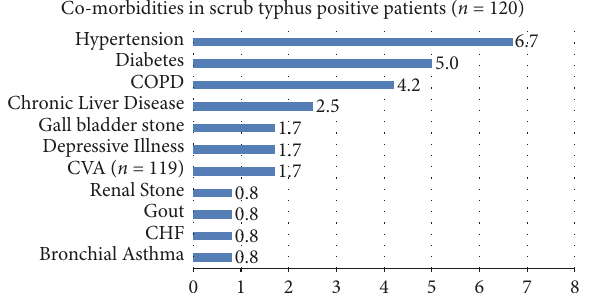
Figure 1: Comorbidities in scrub typhus positive patients. COPD: chronic obstructive pulmonary disease; CVA: cardiovascular acci- dent; and CHF: congestive heart failure.